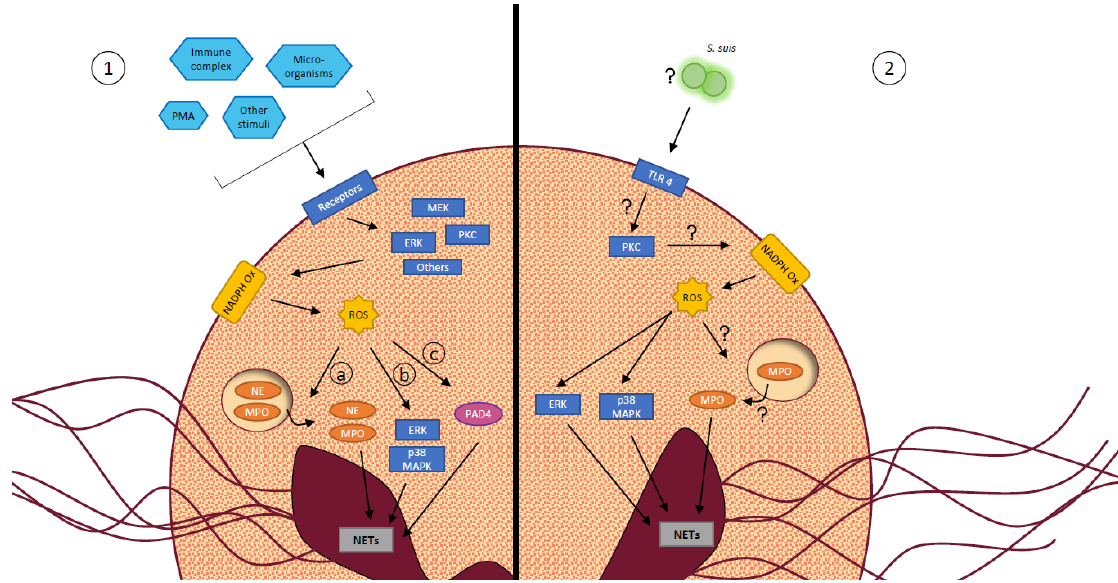
Figure 4. Mechanisms of suicidal NETosis as described using either various stimuli or during S. suis stimulation. An arrow represents an activation, a question mark indicates a mechanism that remains to be further confirmed. ( 1 ) Various stimuli induce neutrophil extracellular trap (NET) formation by neutrophils, including bacteria, phorbol 12-myristate 13-acetate (PMA) and immune complexes. Dependent on the stimuli, the engaged cellular receptors trigger the activation of intracellular pathways (e.g., MEK, ERK or protein kinase C (PKC)), which then lead to the activation of the NADPH oxidase (Ox). This enzyme, pivotal in the formation of NETs, catalyzes reactive oxygen species (ROS) production which is involved in: (a) the release of myeloperoxidase (MPO) and neutrophil elastase (NE) from the granules, which then translocate into the nucleus and participate in chromatin decondensation; (b) the activation of ERK and p38 MAPK that transmit signal for NET formation; and (c) the activation of the peptidyl arginine deiminase 4 (PAD4), an enzyme that citrullinates histones in the nucleus, a feature of NETosis. Only a few of those mechanisms were studied for the induction of NETs by S. suis. ( 2 ) S. suis -induced NET formation might depend on Toll-like receptor 4 (TLR4), PKC and NADPH Ox; however, no other receptors or signaling pathways upstream of NADPH Ox were studied. ROS produced by NADPH Ox activates ERK and p38 kinases which participate in NET formation. Despite a role for MPO in NET formation induced by S. suis , the intervention of ROS in its release from granules remains to be studied.